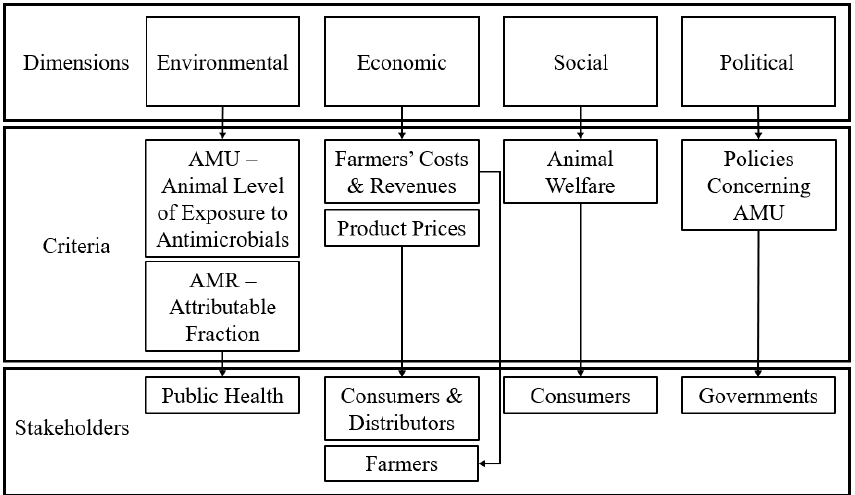
Figure 4. Multi-criteria decision analysis flowchart used to determine criteria and stakeholder groups involved in AMU in French dairy industry. AMU: antimicrobial use. AMR: antimicrobial resistance.